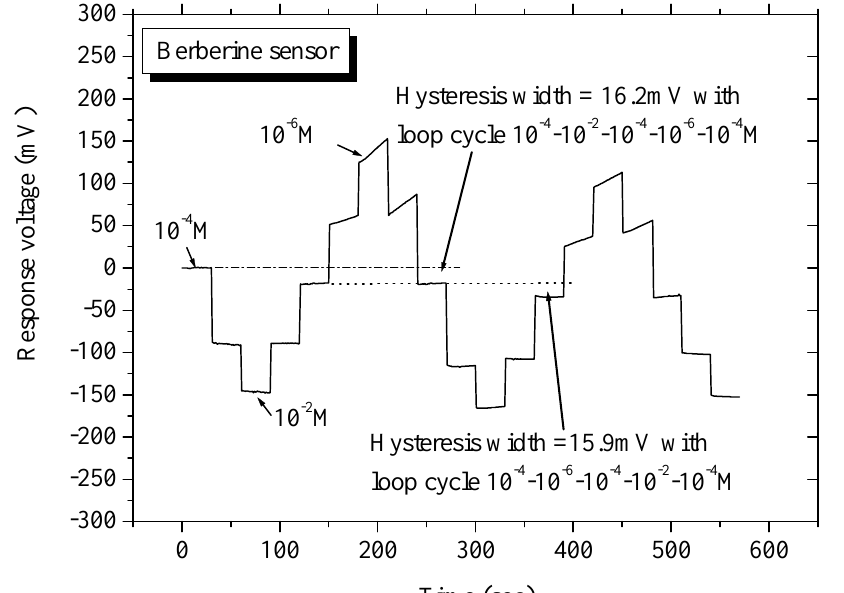
Figure 7. Hysteresis widths of berberine drug sensors based on ruthenium dioxide membrane with the 10 -4 -10 -2 -10 -4 -10 -6 -10 -4 M and the 10 -4 -10 -6 -10 -4 -10 -2 -10 -4 M of berberine concentrations loop